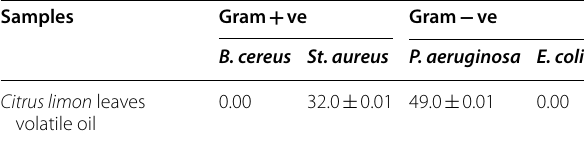
Table 2 Antibacterial activity of Citrus lemon leaves oil against some pathogenic bacteria by well diffusion